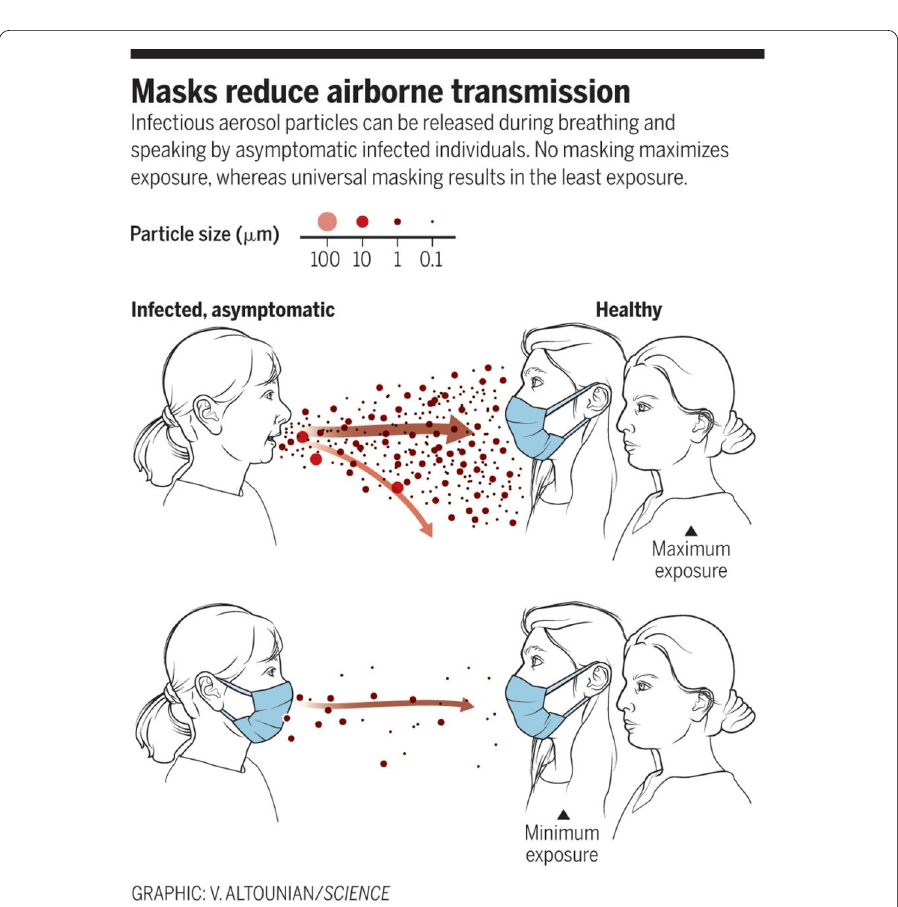
Figure 1 Graphic of V. Altounian [26], showing that masks reduce airborne